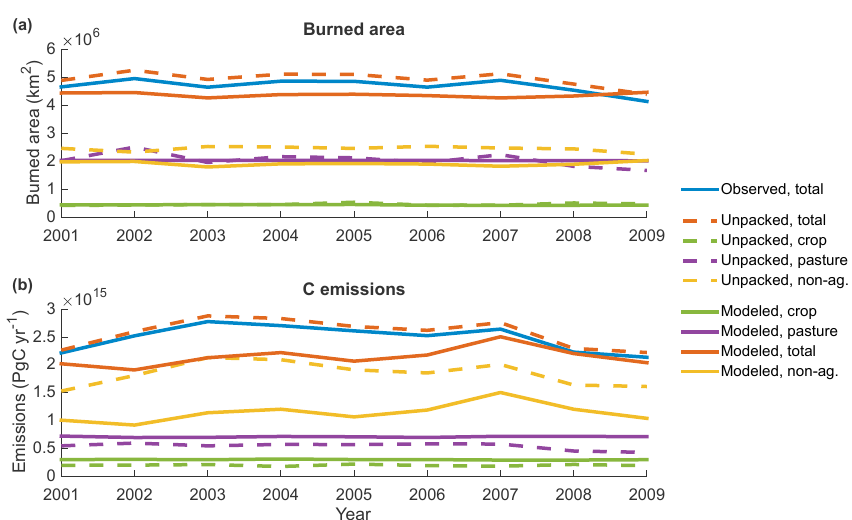
Figure 7. Annual time series of observed and model-estimated burned area ( a) ( km 2 ), and fire carbon emissions ( b) ( PgCyr − 1 ), from 2001 to 2009. Dashed lines: observational estimates of total and by-land cover fire emissions from Rabin et al. (2015). Solid blue lines: observations of total emissions from GFED3s (Randerson et al., 2012). Other solid lines: model-estimated total and by-land cover fire